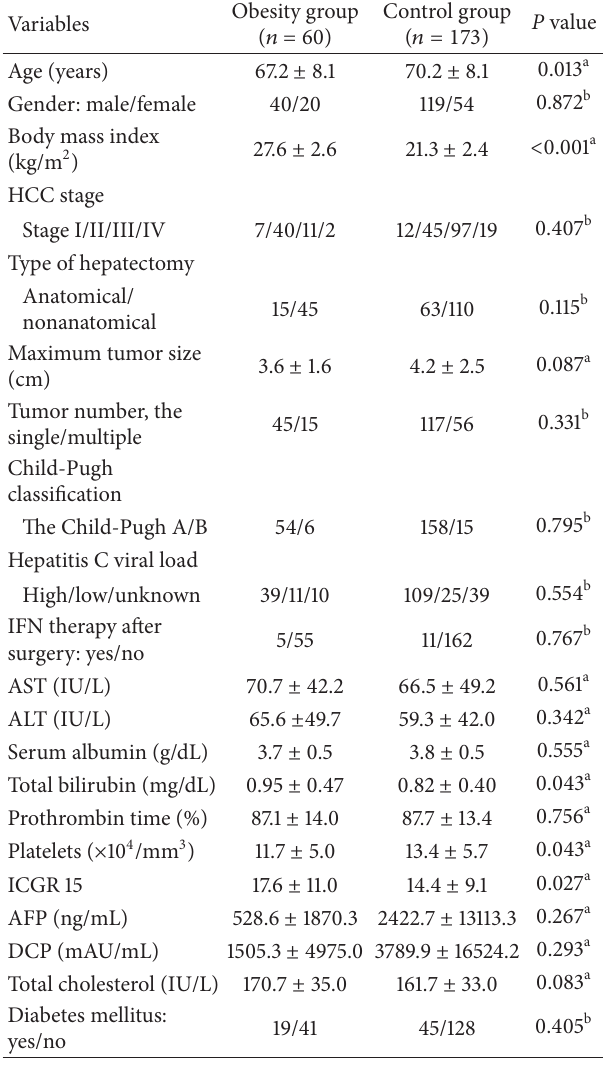
Table 1: Baseline characteristics between the obesity group and the control